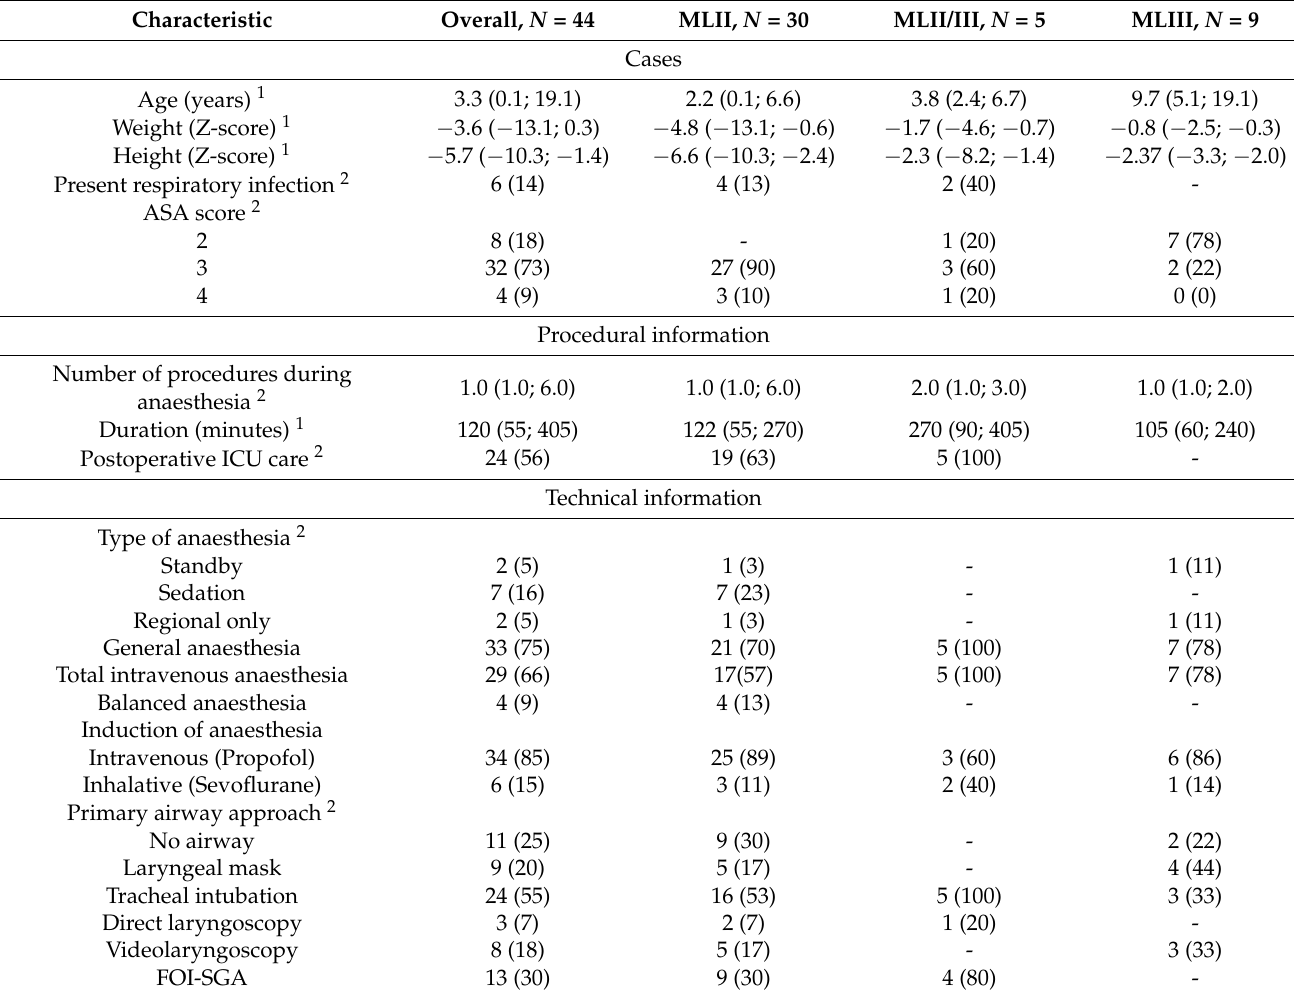
Table 2. Characteristics of anaesthesia